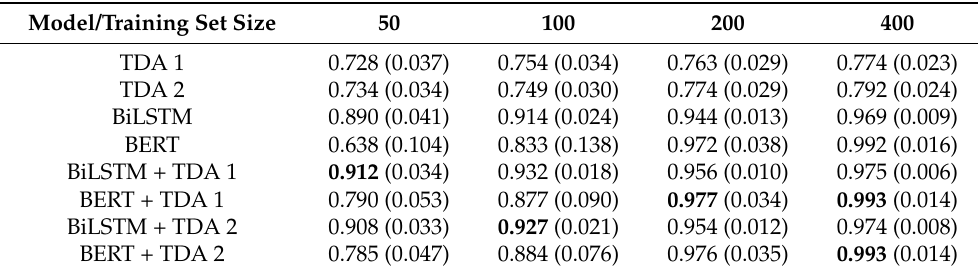
Table 3. We trained each of 8 models (TDA 1, TDA 2, BiLSTM, BERT, and ensembles of BERT with TDA 1 and TDA 2) 50 times on a randomly chosen training set. We did it for training sets of sizes 50, 100, 200, and 400. Average test accuracy and the standard deviation are reported in this table. The highest test accuracy for each training set size is bolded.